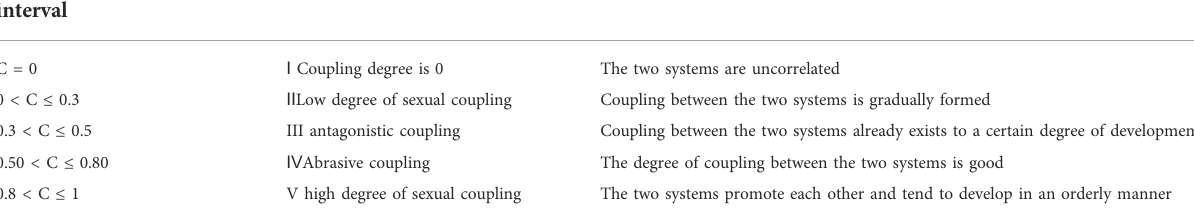
TABLE 1 Classi fi cation of coupling degree interval types.